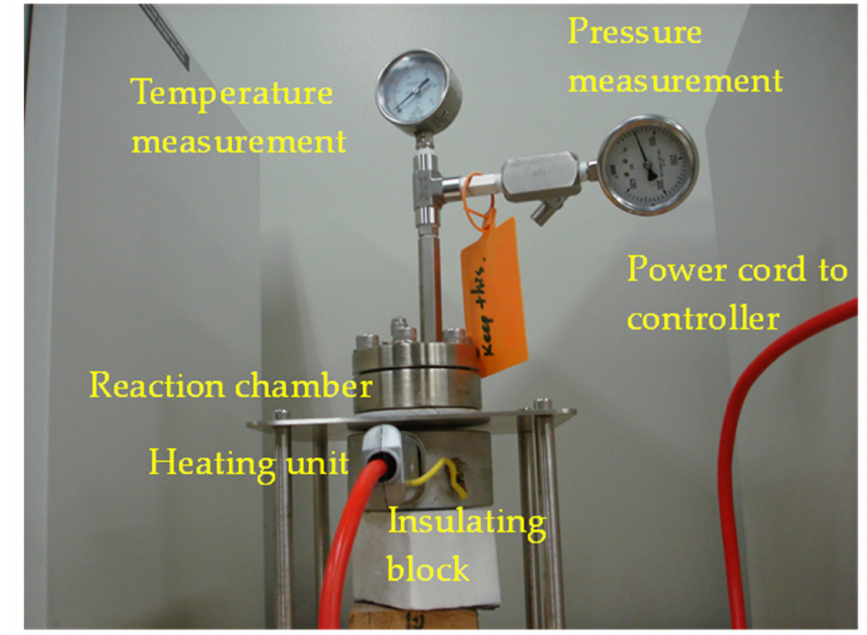
Figure 1. Photo showing the hydrothermal carbonization facility.